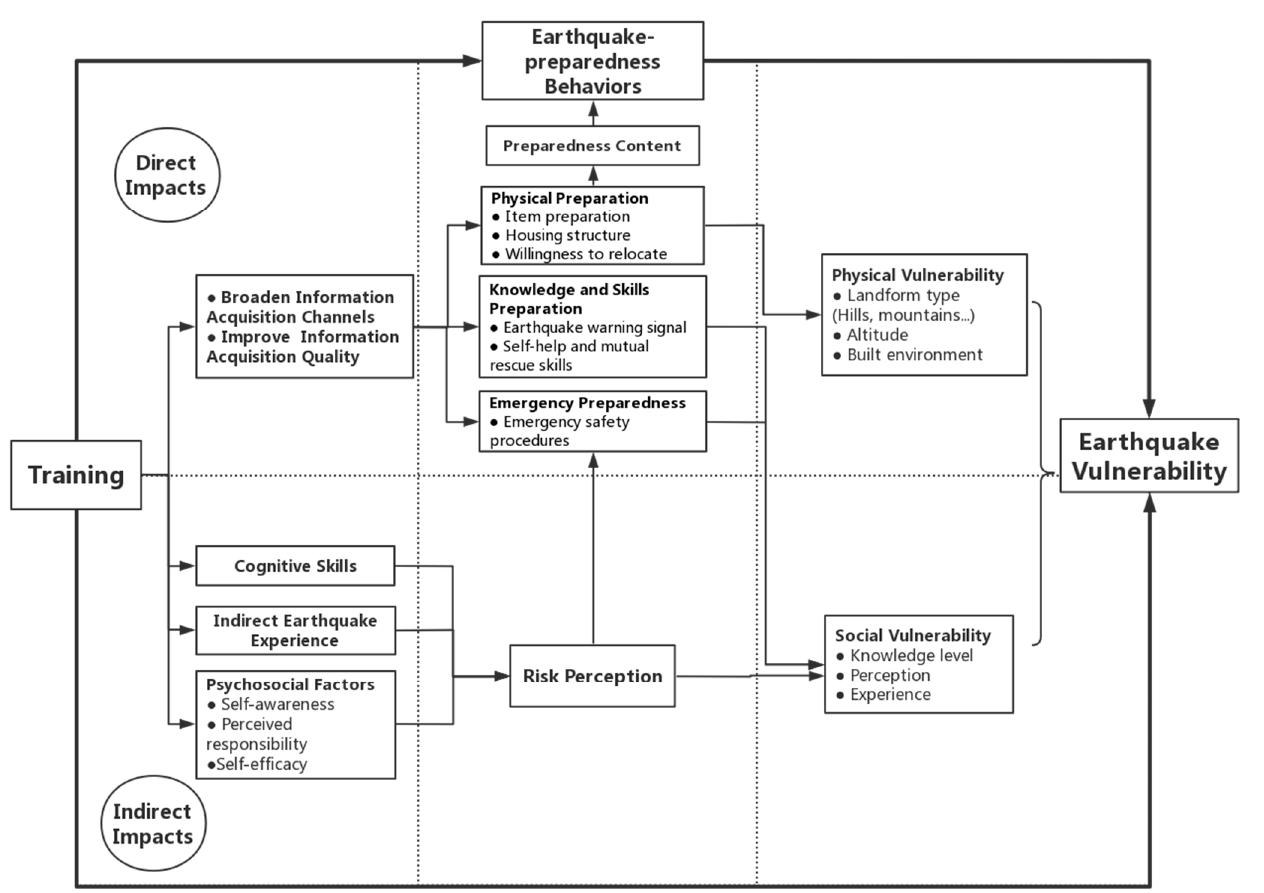
Figure 2. Theoretical analysis framework of the impact of training on farmers’ earthquake-preparedness behaviors.